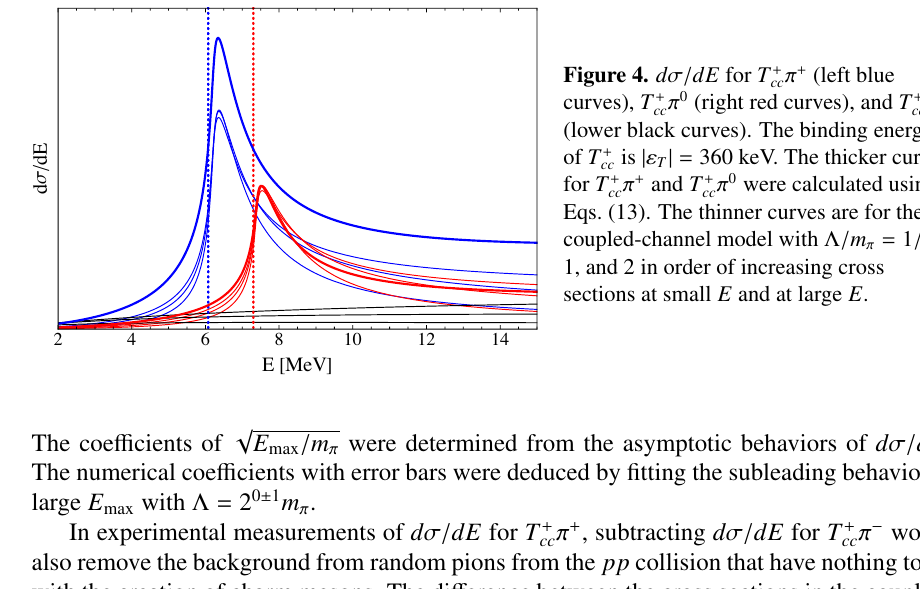
Figure 5. Di ff erence between the π + di ff erential cross sections d σ/ dE for T + cc π − in the coupled-channel model as and T + cc functions of the invariant kinetic energy E . The binding energy of T + is cc | ε | = 360 keV. The curves were calculated T using Eqs. (14a) and (14c) with Λ / m = 1 / 2, 1, and 2 in order of increasing π cross sections at small E and at large E